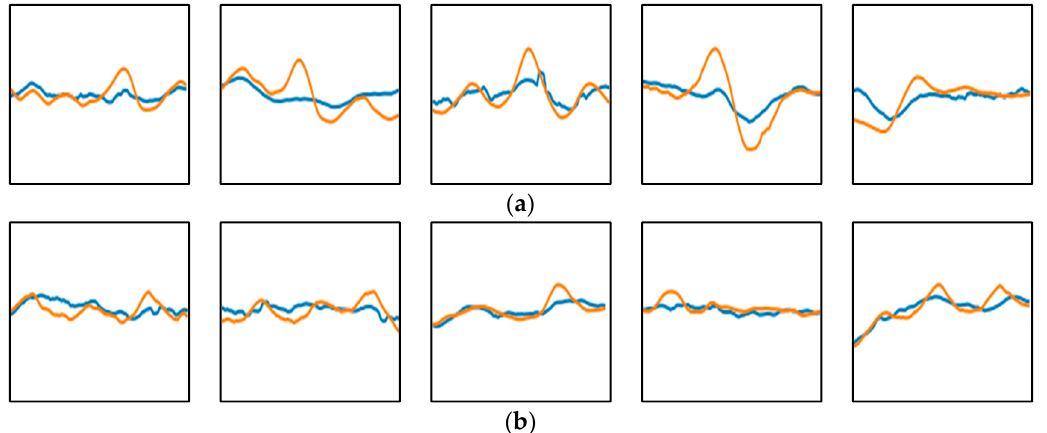
Figure 13. Examples of detected and undetected arching images in the testing set using the proposed model. ( a ) Examples of correctly detected arching images that cannot be detected by DNN; ( b ) Examples of undetected arching images.